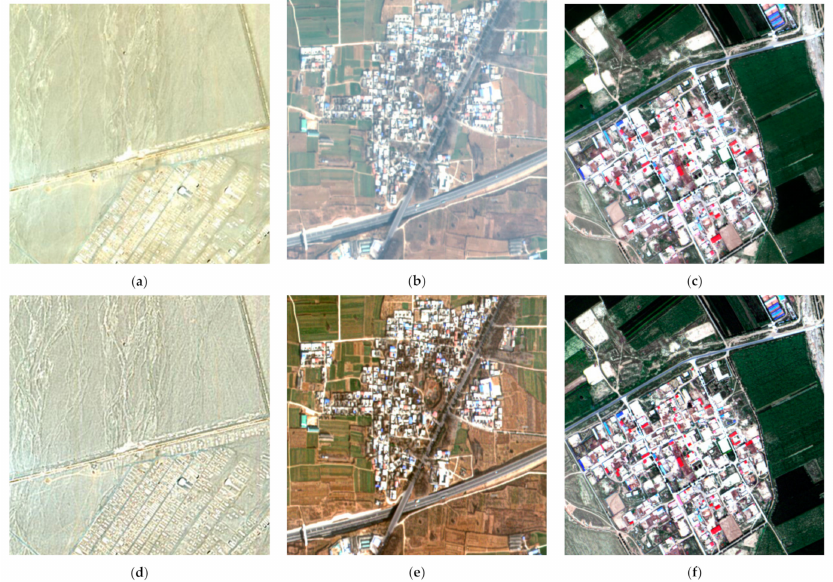
Figure 7. True color images of main sensor of GFDM satellite. Image ( a ) is part of the image